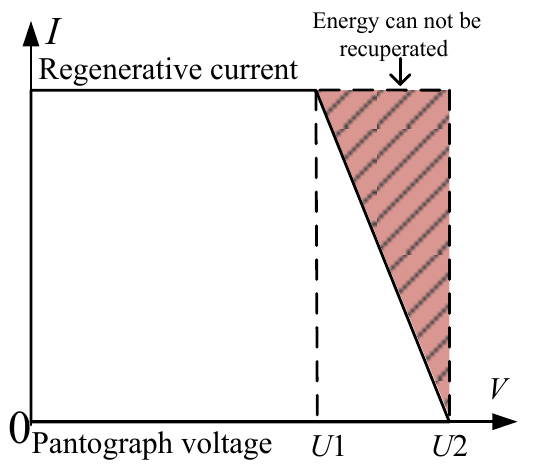
Figure 3. Ideal regenerative current limit curve of urban rail